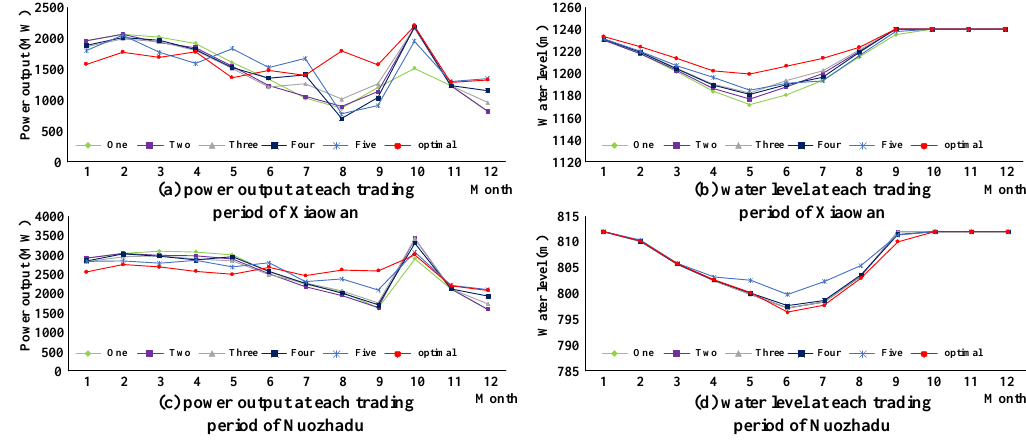
Figure 9. Generating schedules of Xiaowan and Nuozhadu under different regulation scenarios: ( a ) power output at each trading period of Xiaowan; ( b ) water level at each trading period of Xiaowan; ( c ) power output at each trading period of Nuozhadu; ( d ) water level at each trading period of Nuozhadu.